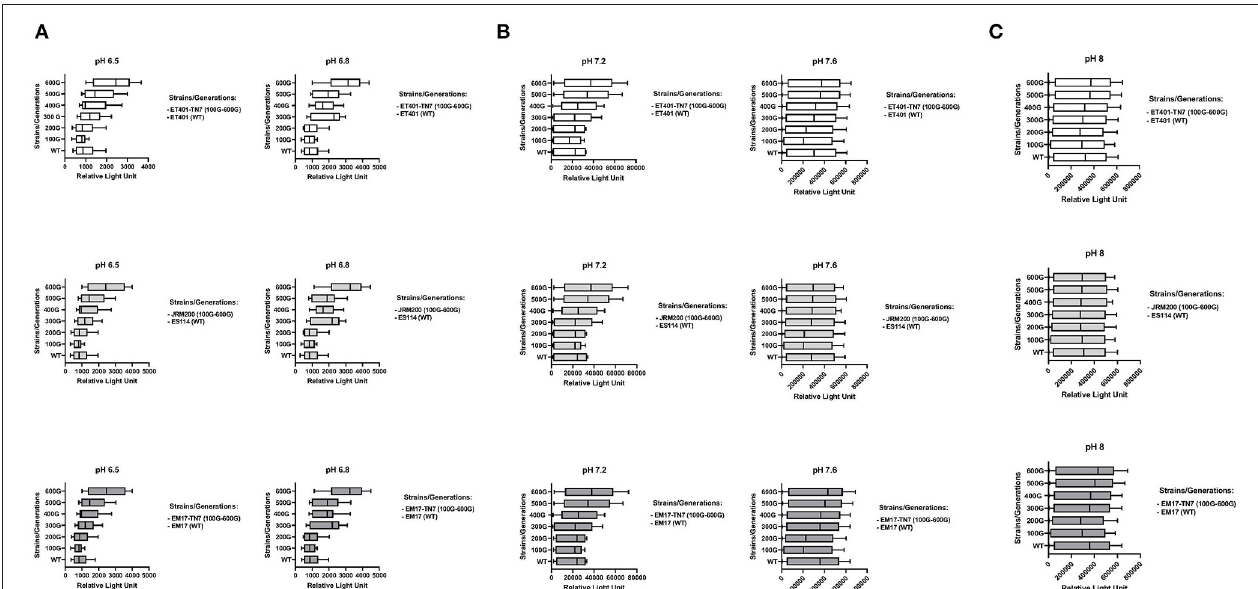
FIGURE 2 | Bioluminescence (relative light units) during growth of ancestor and their evolved strains from 100 to 600 generations at (A) pH = 6.5 and pH = 6.8 ET401, JRM200, and EM17, (B) pH = 7.2 and pH = 7.6 ET401, JRM200, and EM17 (C) pH = 8 ET401, JRM200, and EM17. See Table 1 for strain